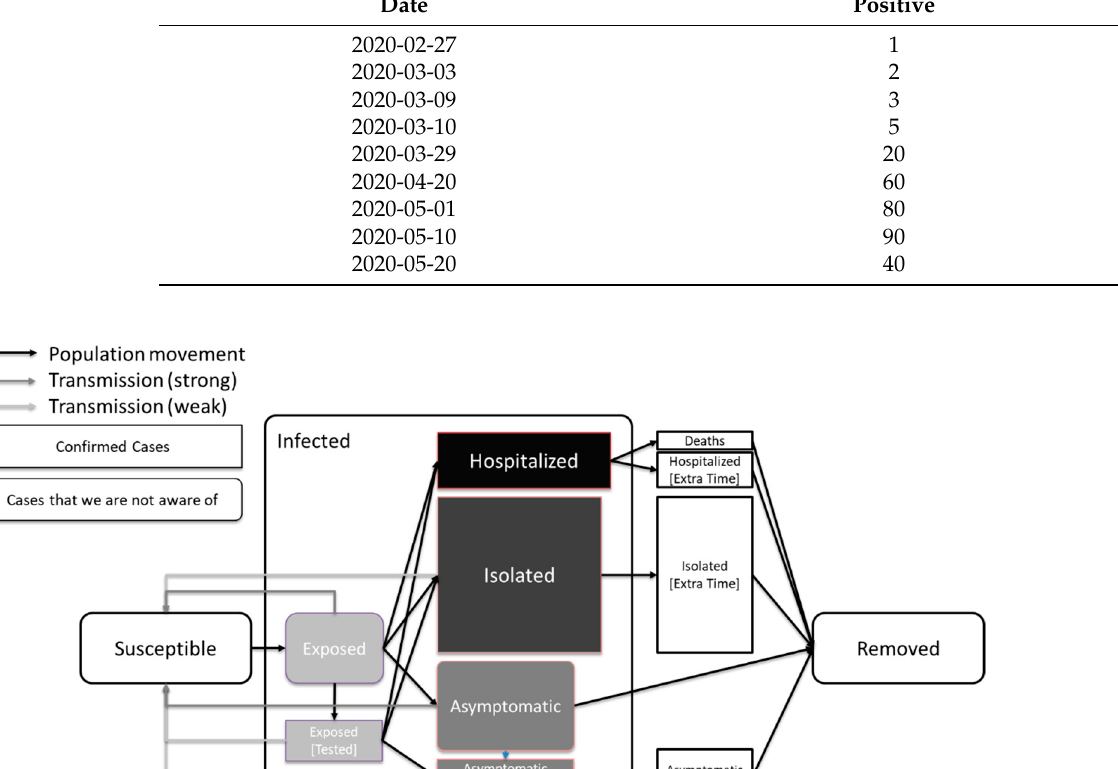
Table 2. The assumed positive cases detected over time that can result from random tests. The numbers below are only assumptions, since we do not have the official test data about positive cases found on people randomly sampled from the population.